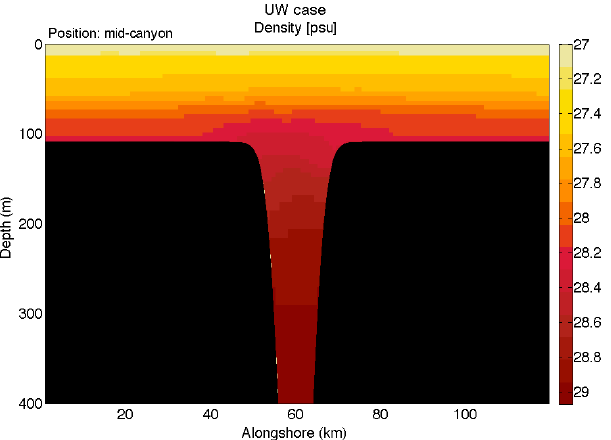
Figure 11. Isopycnal cross section at mid-canyon in the core simu- lation (UW).